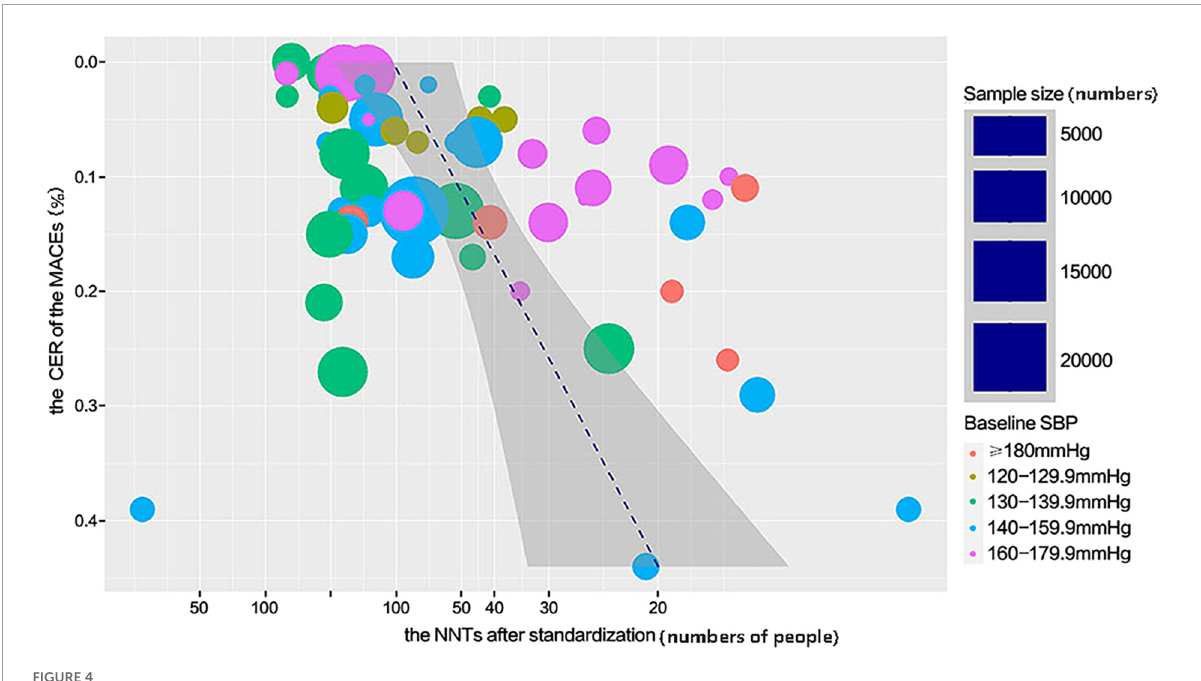
FIGURE4 The relationship between the NNT of the MACEs and the CER of the